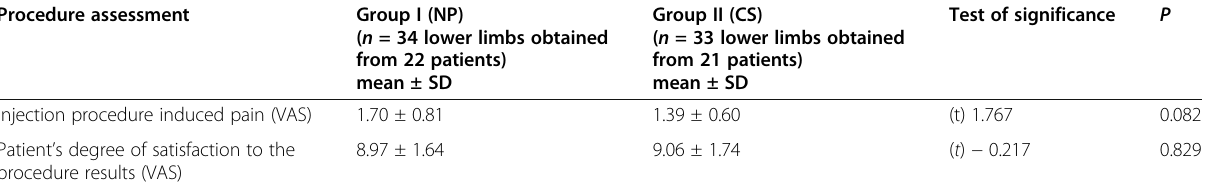
Table 3 Comparison between the two treatment groups regarding procedure assessment Procedure assessment